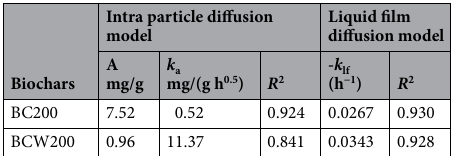
Table 3. The fitting results of the intraparticle diffusion model and liquid-film diffusion model.